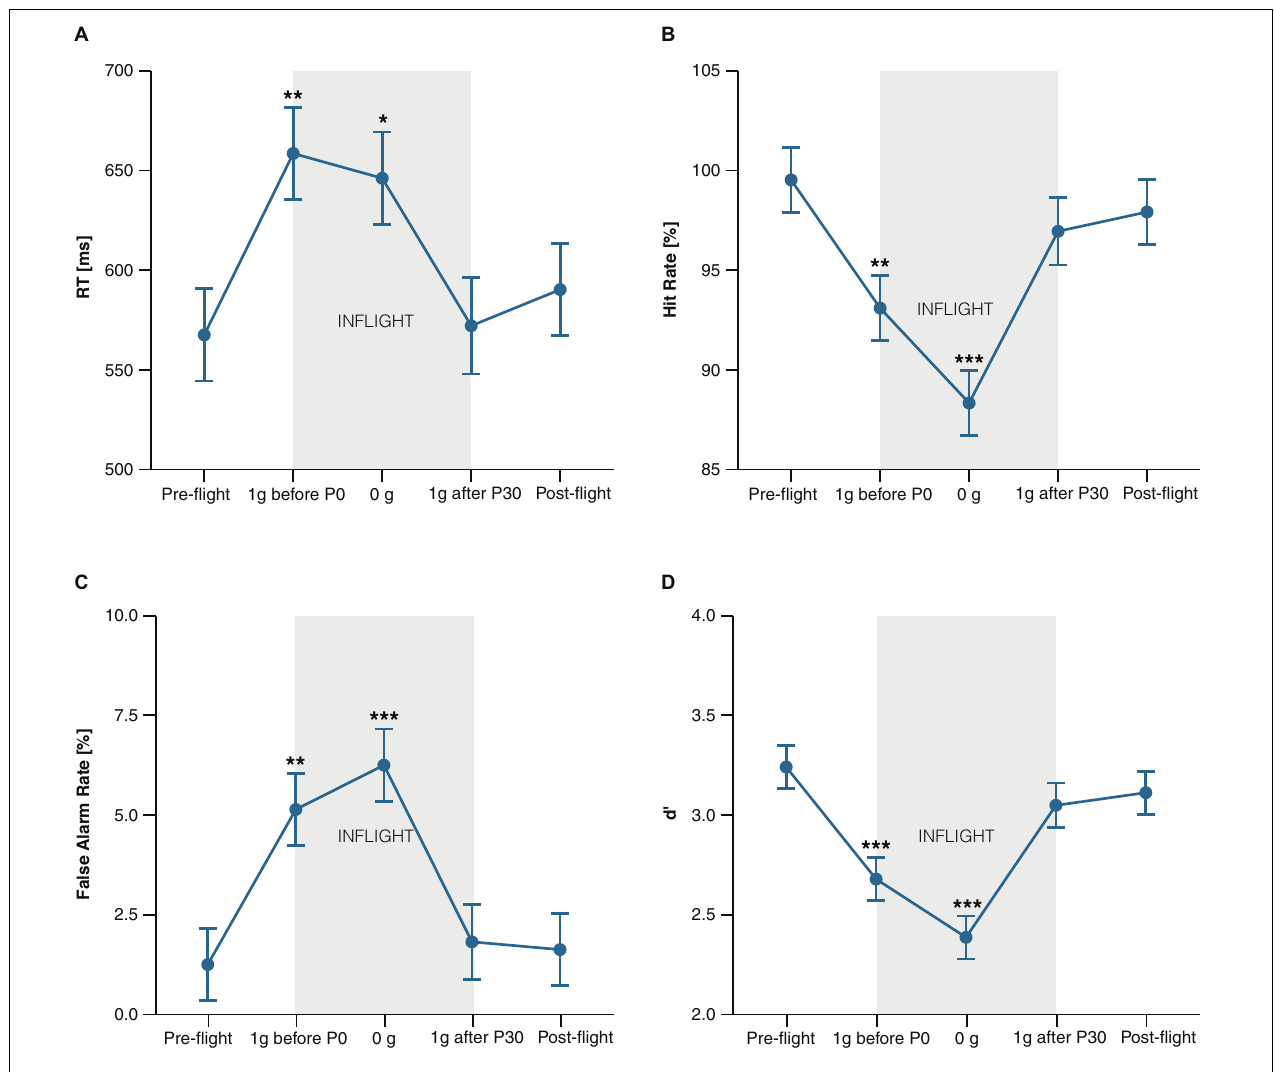
FIGURE 3 | CPT performance. (A) Reaction Time of target stimuli in ms; (B) Hit Rate (correct reactions to target stimuli) in percentage; (C) False Alarm Rate (reactions to non-targets) in percentage; (D) d’ (indicator for task sensitivity). Data is presented as marginal means ± SE and was collected at the following points in time: Pre-flight (30 min after scopolamine injection), inflight at 1 g before the first parabola (1 g before P0.), during microgravity (0 g), at 1 g after the last parabola (1 g after P30), and after landing (Post-flight). * P < 0.05, ** P < 0.01, *** P < 0.001 compared to pre-flight.